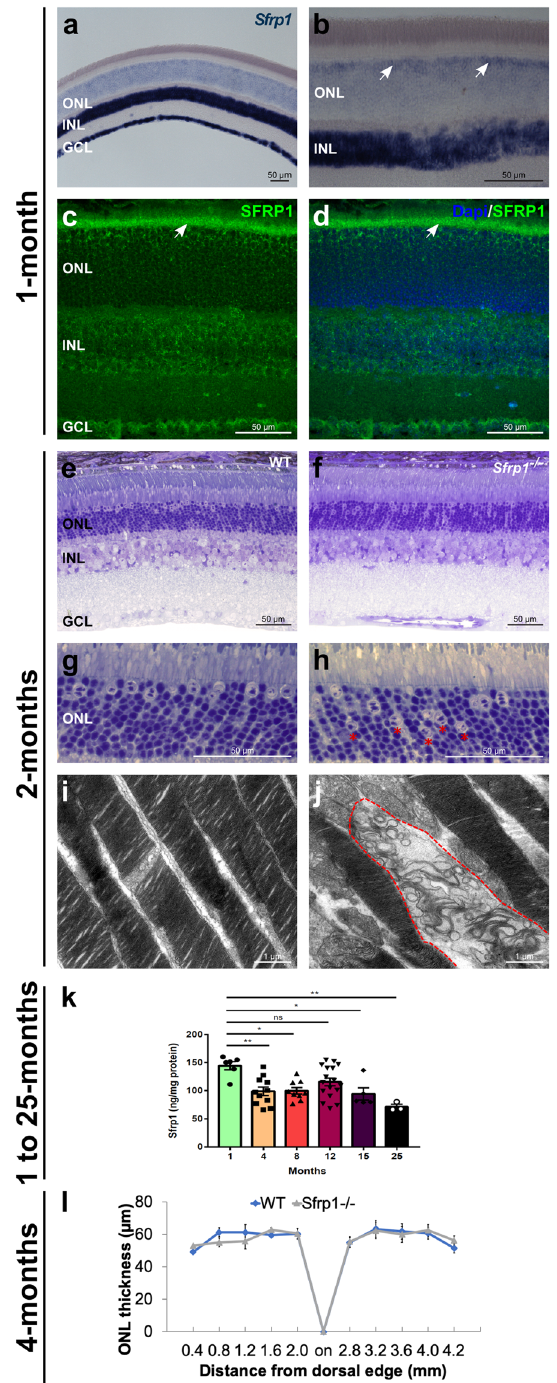
Figure 1. SFRP1 is expressed in the retina and required for photoreceptor fitness. ( a – d ) Frontal cryostat sections from 1 month-old wt animals hybridized ( a , b ), or immunostained ( c , d ) for SFRP1 and counterstained with DAPI. ( d ) The white arrows in ( b ) indicate the increased signal in the outermost region of the ONL. Note Sfrp1 accumulation in the OLM (arrows in c , d ). ( e–h) Semi-thin frontal sections from 2 months-old wt and Sfrp1 − / − retinas stained with toluidine blue. Note the abnormal localization of cone nuclei in the mutant retina (red asterisks in h). ( i , j) TEM analysis of the OS. Note that in the mutants, but not in wt, the stacks of membranes of the OS are disorganized (area enclosed in dotted line in ( j ). ( k) ELISA analysis of SFRP1 levels in total protein extracts from 1 to 25 months-old retinas from wt mice. Note the significant decrease of SFRP1 content as the animals age; One- way ANOVA, with post hoc Bonferroni analysis; * p < 0.05, ** p < 0.01. ( l) The graph shows the ONL thickness in 4 months-old wt and Sfrp1 − / − retinas (measures were taken in cryostat frontal sections of the eye at the level of the optic disk). No significant differences were detected between wt and Sfrp1 − / − retinas (Mann-Withney U test). Abbreviations: GCL: ganglion cell layer; INL: inner nuclear layer; on: optic nerve; ONL: outer nuclear